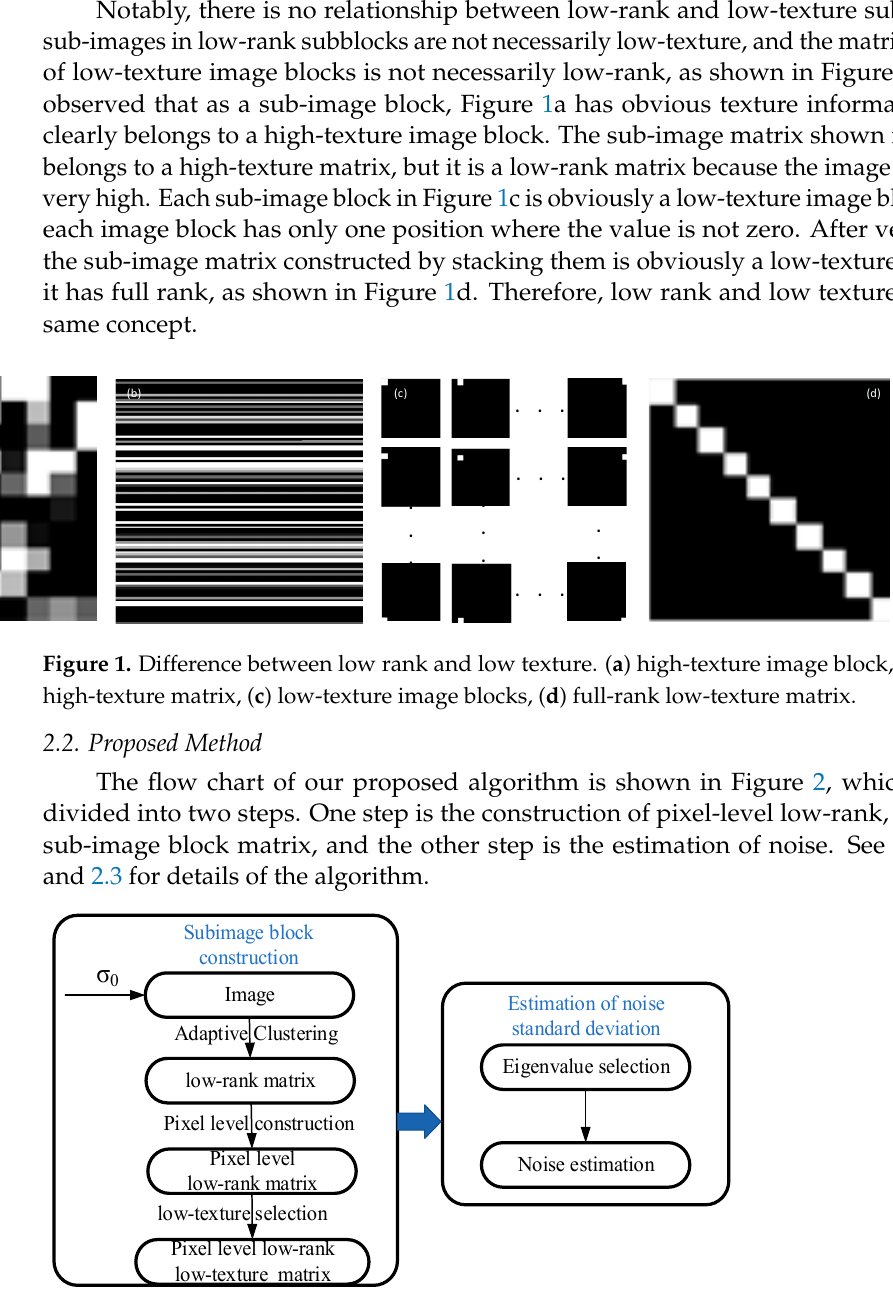
Figure 2. The flowchart of our algorithm.